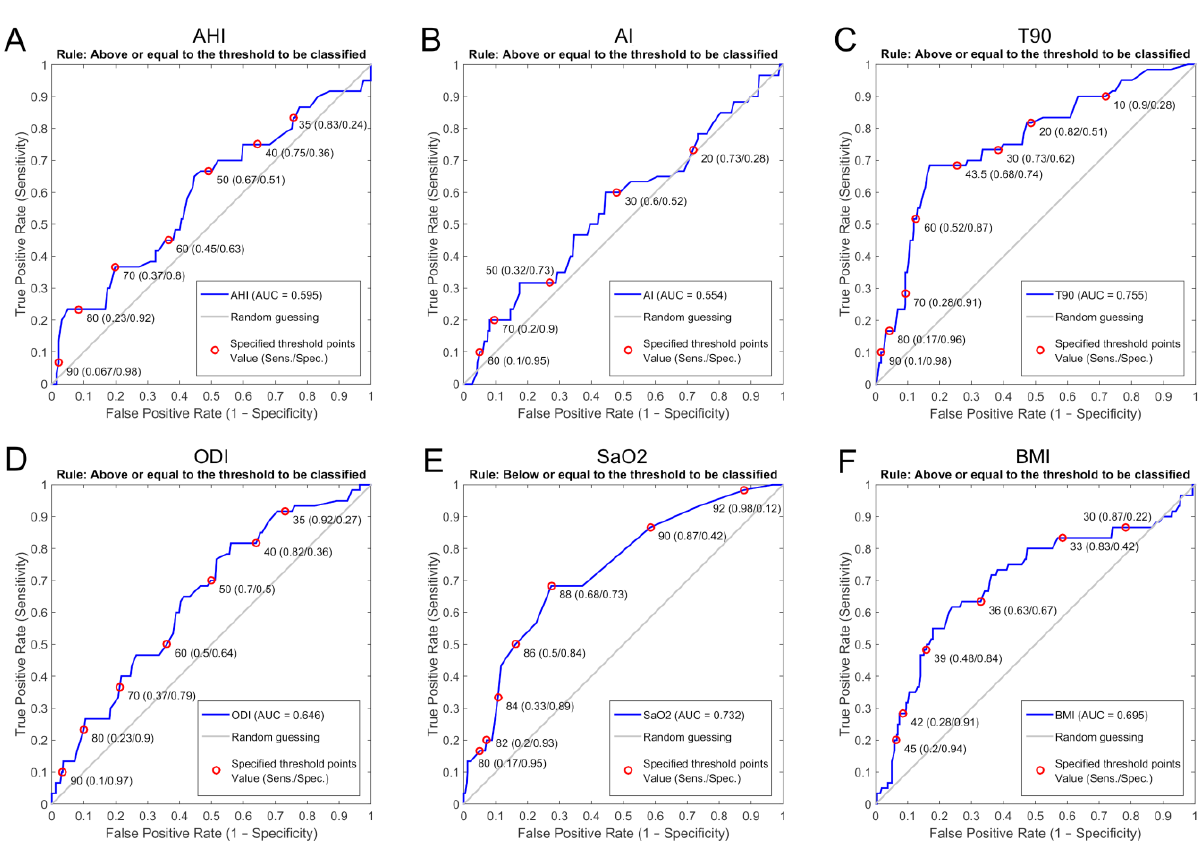
Fig. 2. ROC analysis of the monitored variables with respect to the prediction of CPAP failure. A – AHI, B – AI, C – T90, D – ODI, E – SaO2, F – BMI. Cases compliant with the rule stated above each plot were predicted to fail in